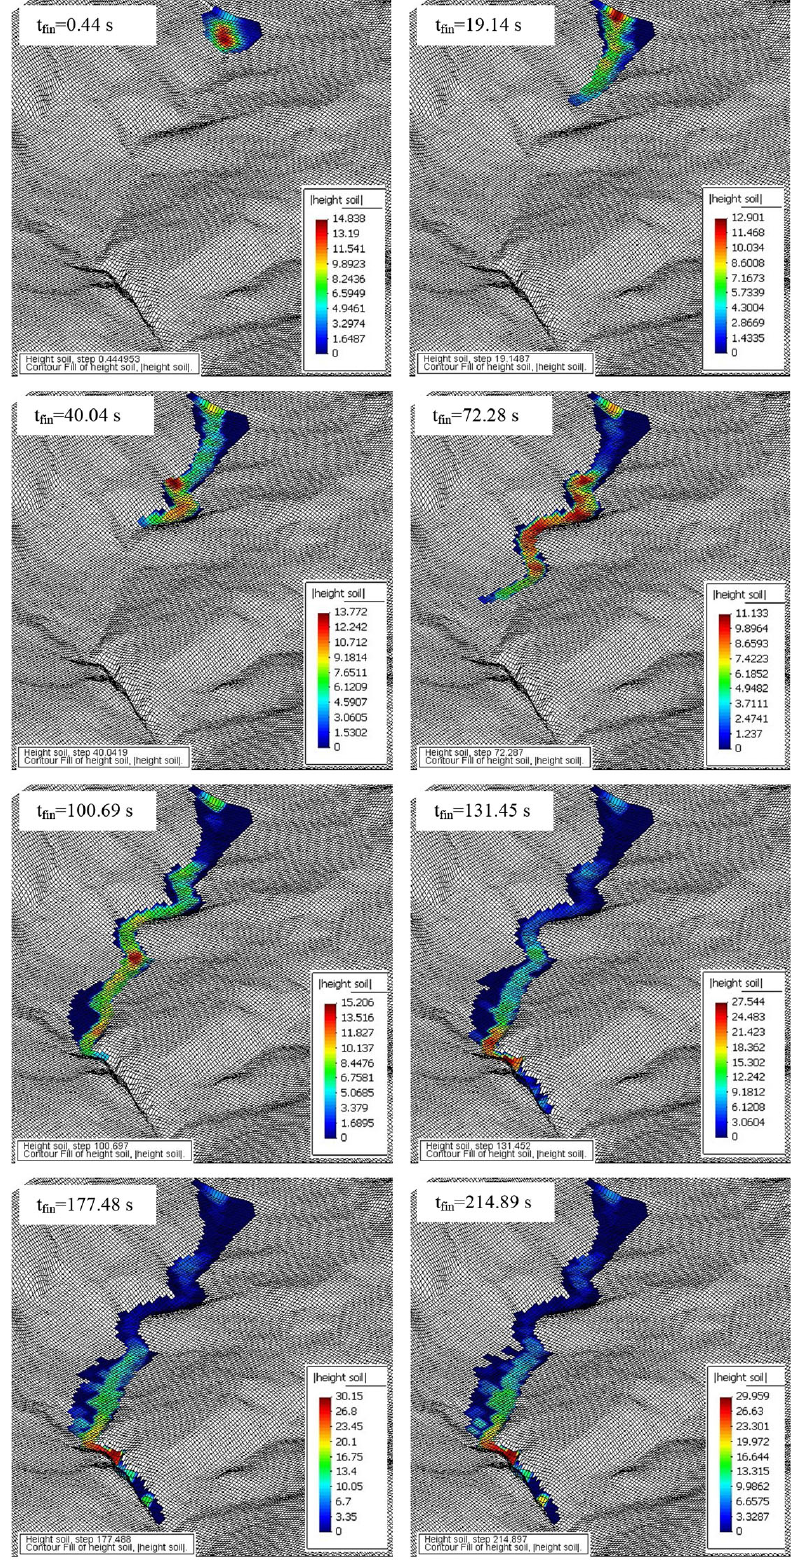
Figure 11. The simulation view of mudflow propagation on the Rjeˇcina River (based on the equidistant mesh grids of 5m × 5m), propagation of materials from natural dam formed on the Grohovo landslide, Simulation